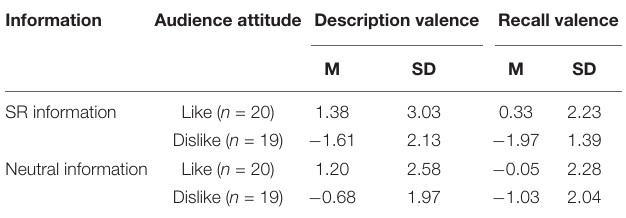
TABLE 1 | Description valence and recall valence as a function of information and audience